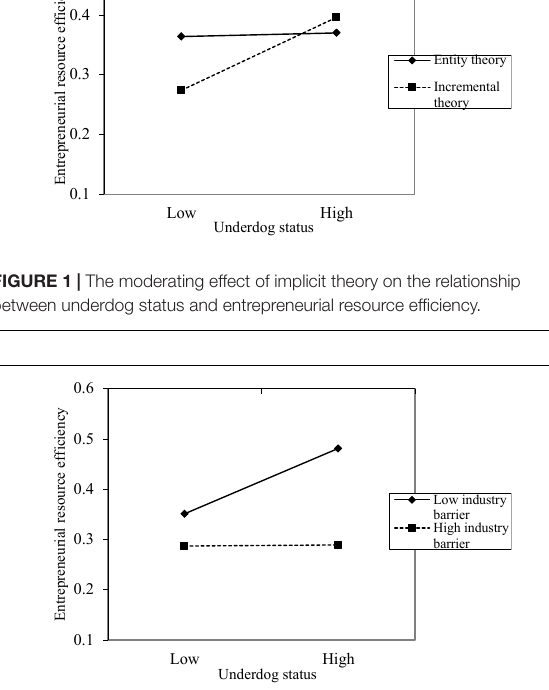
FIGURE 2 | The moderating effect of industry context on the relationship between underdog status and entrepreneurial resource efficiency.